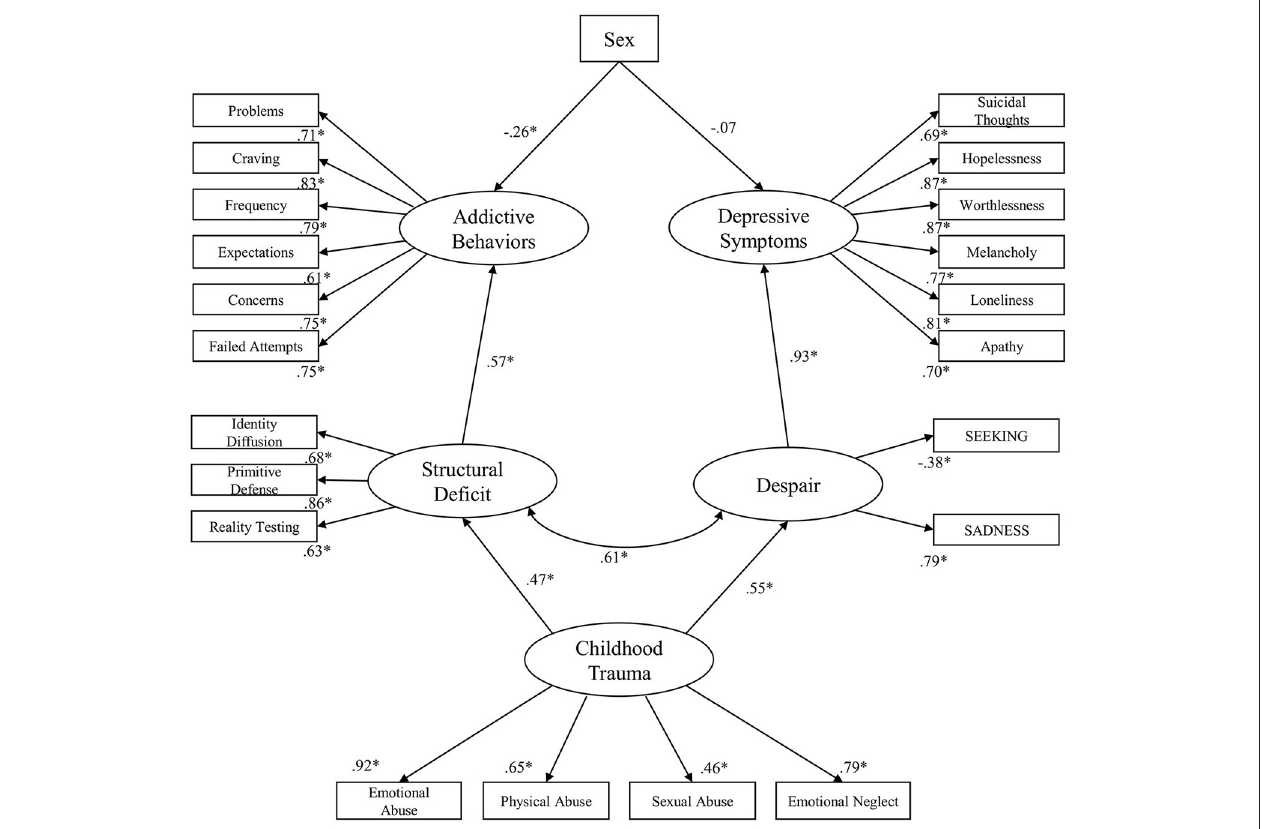
FIGURE 3 | Final standardized solution for the structural equation model; * p < 0.001; Sex: Female = 1; Male =